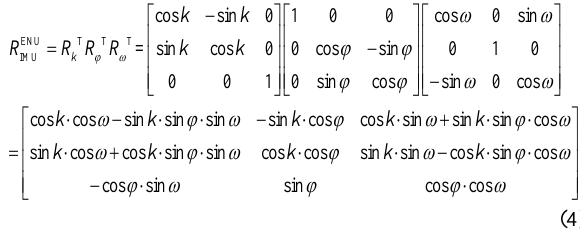
Figure 2 . Process of solving rotation